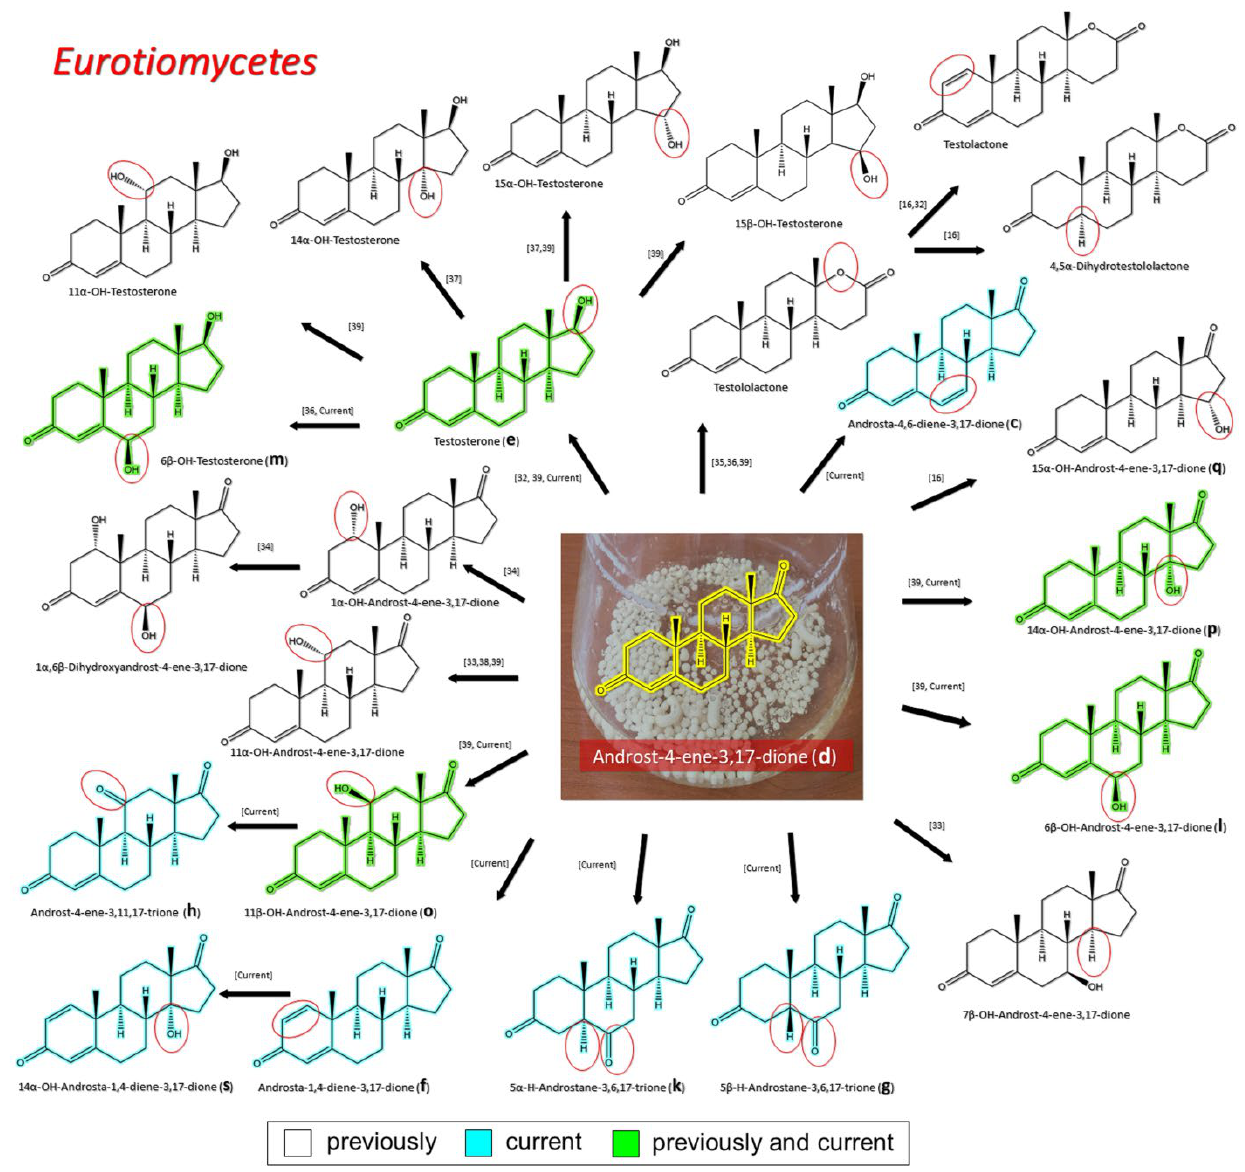
Figure 4. The transformation of androst-4-ene-3,17-dione ( d ) by Eurotiomycetes (family Aspegillaceae ). Structural formula of the substrate ( d ) is drawn in yellow and placed on the image of the flask with defined (DE) medium after 48 h of transformation for by Aspergillus versicolor STG-86. Structural formulas of steroids detected during the transformation are drawn: in green for compounds found both in current and in other studies; in black for compounds found in other studies, but not found in current work; and in blue for compounds first discovered in current study. Next to the arrows are the literary sources, where modifications were described; modifications circled in red ovals.